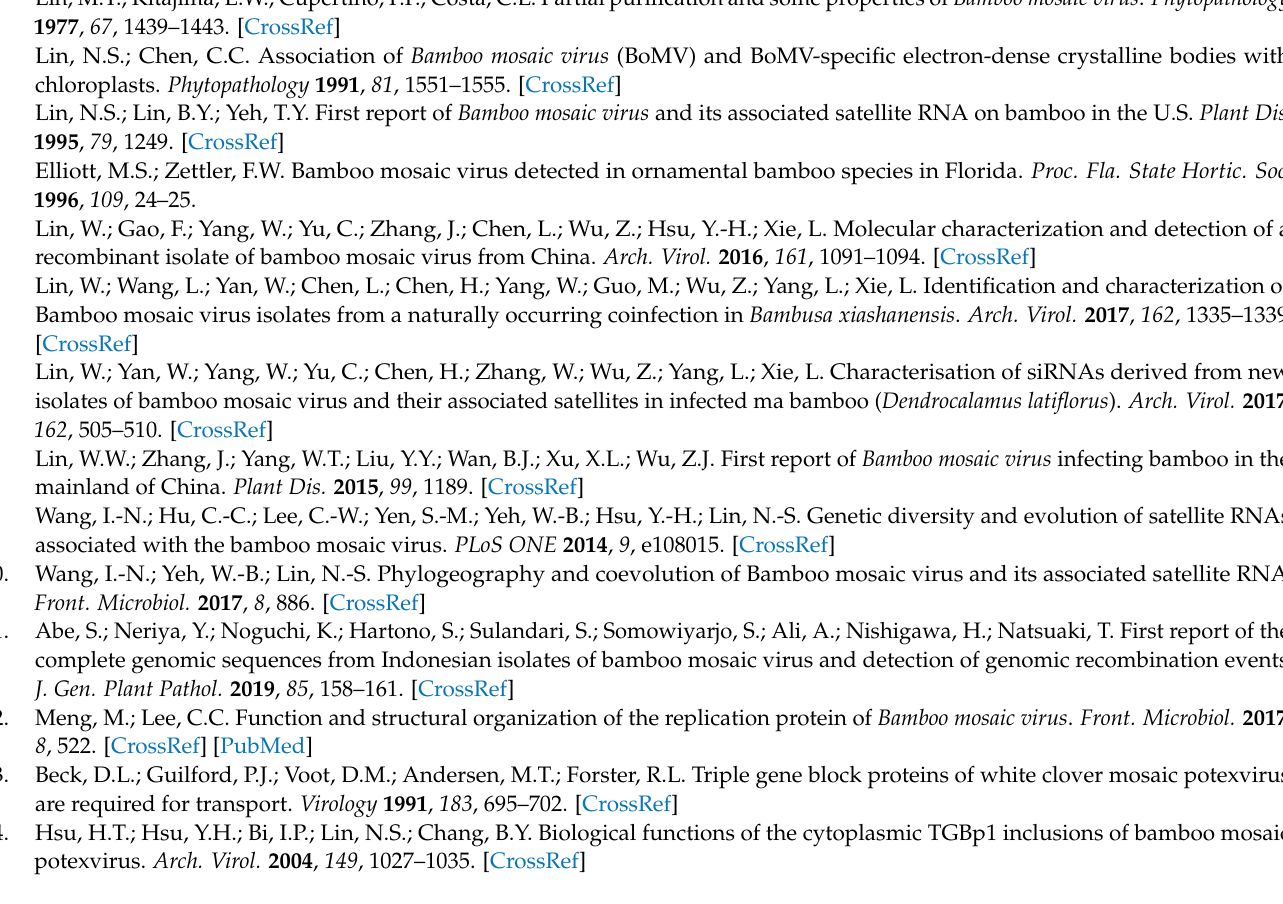
genome sequences are indicated by the red arrows on the right; Table S1. Percent nucleotide sequence identities between a selected Bamboo mosaic virus Vietnam isolate (BaMV-VN2-9) and other known BaMV strains in different